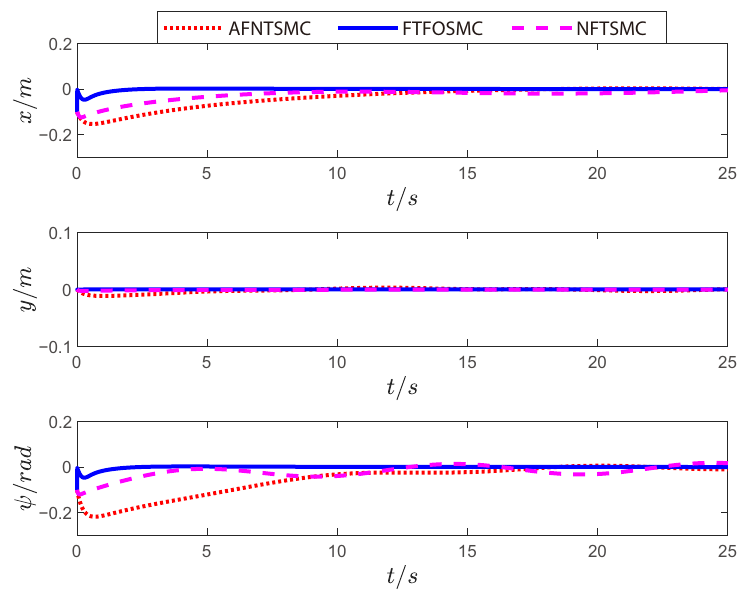
Figure 4. USV trajectory tracking error